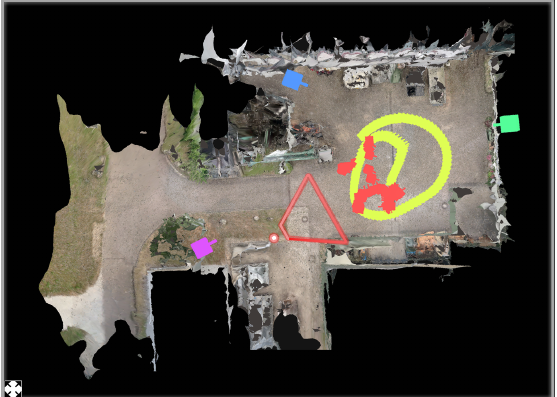
Figure 14. Minimap depicting a top-down view of the reconstructed environment. The locations of the cameras recording the investigated incident are displayed as small camera icons (3 static cameras: blue, green, and magenta; 2 moving cameras: red and yellow). The current location of the user is shown as a small dot, with a red frustum indicating the viewing direction (center) and field of